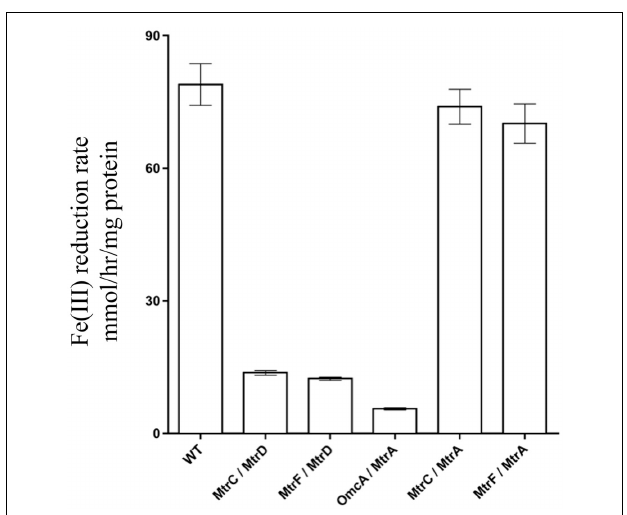
FIGURE 4 | Iron(III) citrate reduction by Δ Mtr/ Δ mtrE complemented strains. Iron(III) citrate reduction rate of Δ Mtr/ Δ mtrE complemented strains. Rates are reported in millimolar per hour per microgram protein.